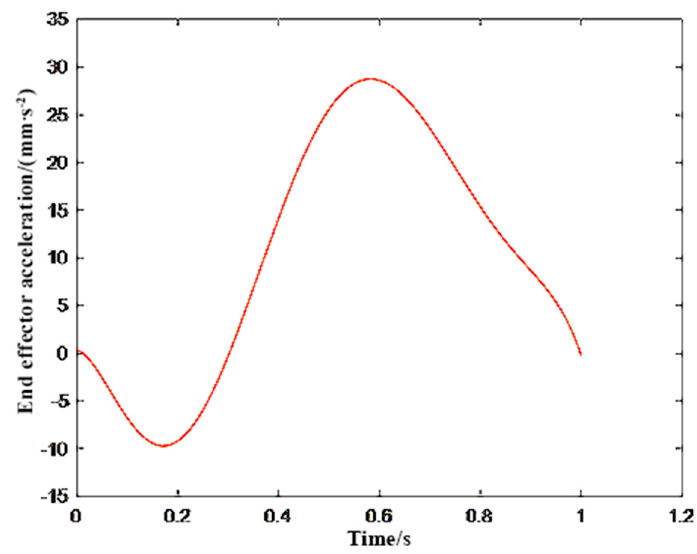
Figure 13. End effector acceleration variation.